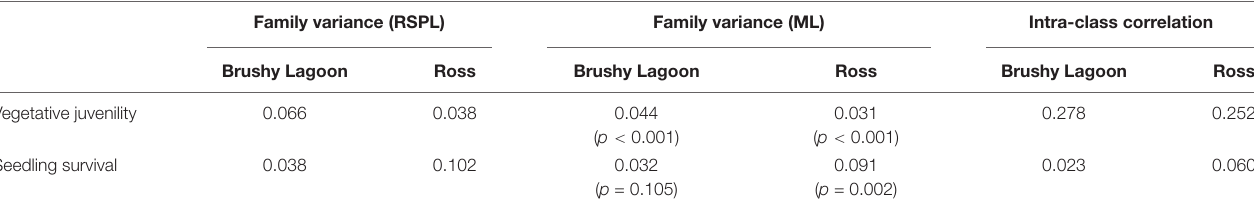
TABLE 4 | Family variances estimated by residual-pseudo likelihood (RSPL) and maximum likelihood (ML), and estimates of intra-class correlation (ICC) coefficients, for discrete variables (vegetative juvenility and seedling survival) measured in the mesic (Brushy Lagoon) and dry (Ross) populations of E. pauciflora .